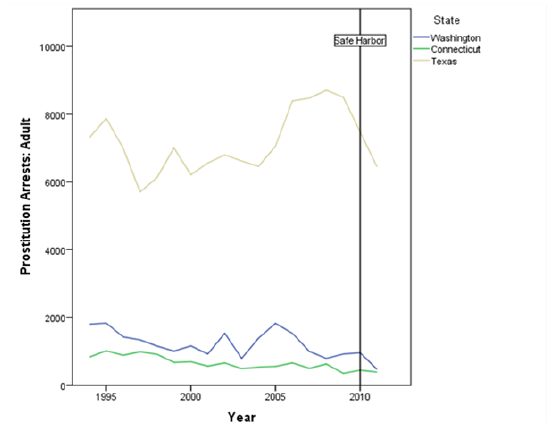
Figure 4. Adult prostitution arrests: Connecticut, Texas, and